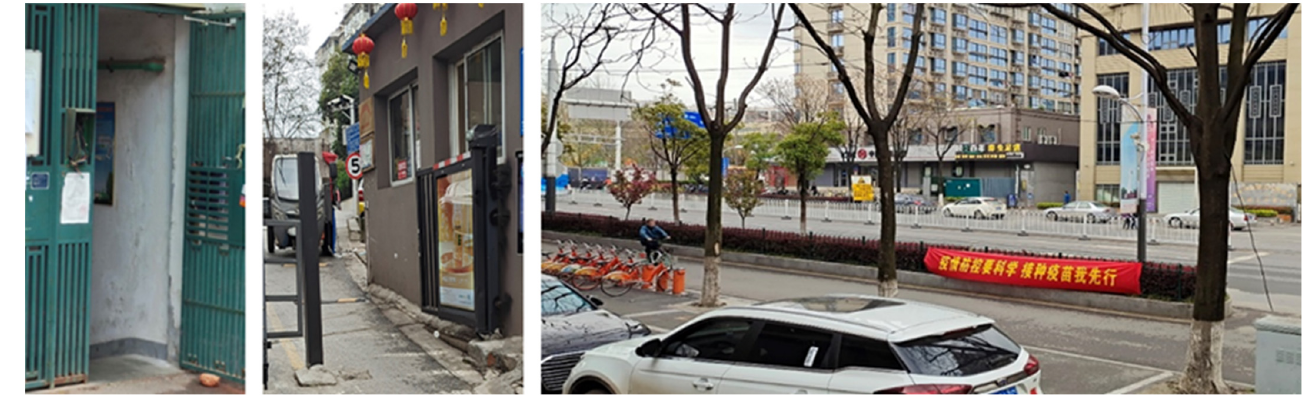
Figure 11. District entrance and exit (photographed by Yuxin Xu in 2022). Table 3. Score after